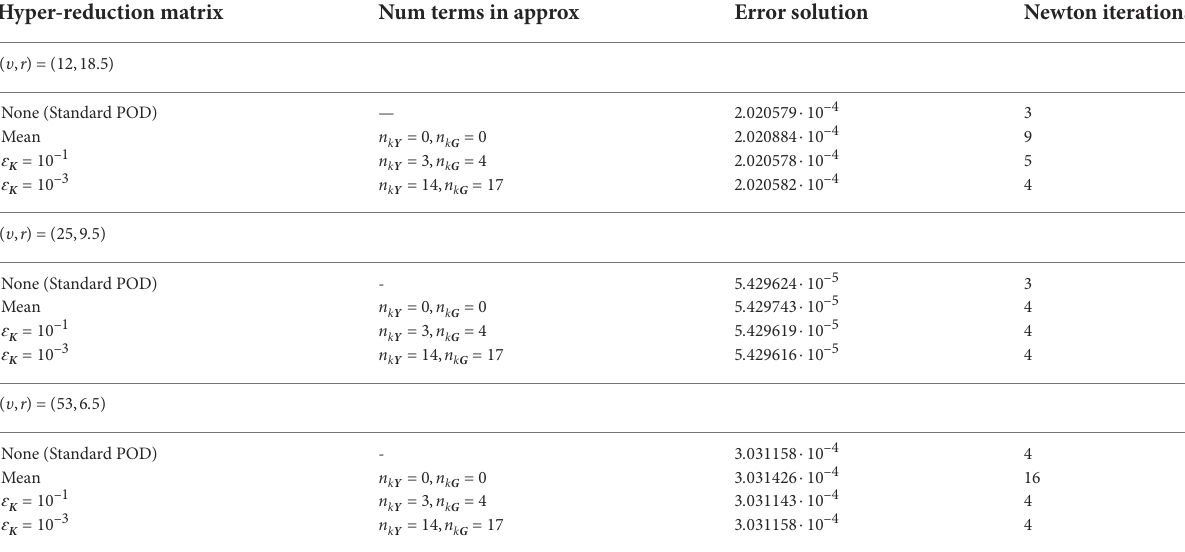
TABLE 2 RelativeerrorsandnumberofNewtoniterationswhenapproximating onlythematrix inthePODformulationwithhyper-reduction.The hyper-reductiontakes n kY and n kG termsinapproximations(Eq. 34)and(Eq. 35)for A 1 and A 2 ,respectively.Solutionscorrespondingtoparameters ( υ , r ) = ( 12 , 18 . 5 ) , ( 25 , 9 . 5 ) and ( 53 , 6 . 5 ) .Trainingsetwith42snapshots,whichleadstoreducedsystemsofdimension n k = 16. Hyper-reduction matrix Num terms in approx Error solution Newton